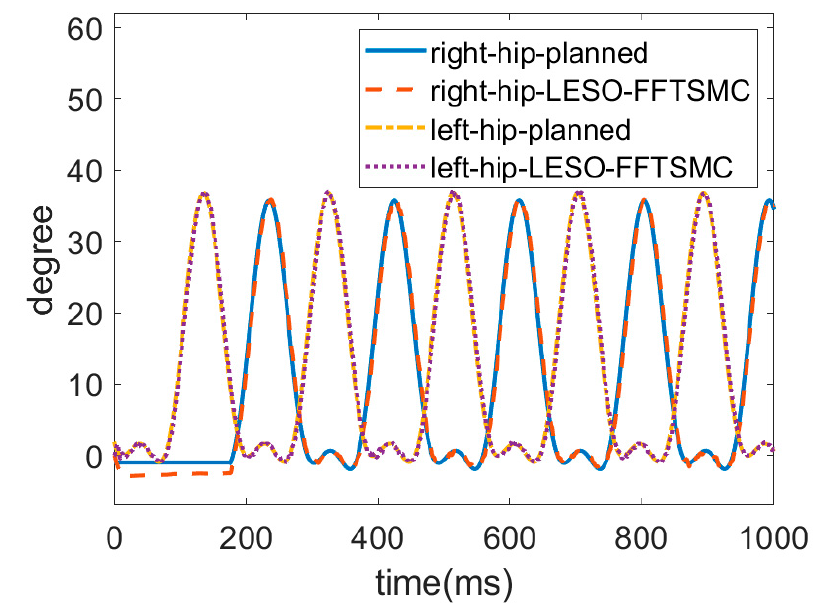
Figure 11. Trajectories of hip joint by LESO-based FFTSMC at walking speed = 0.15 m/s.